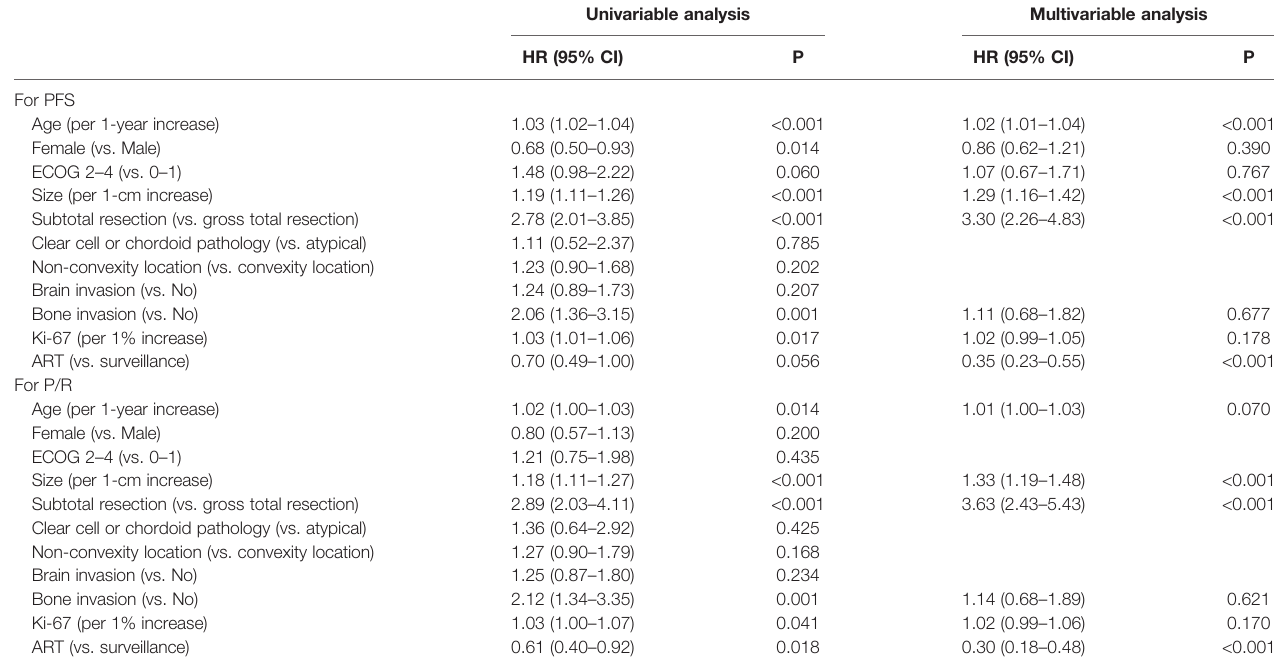
TABLE 2 | Prognostic factors for PFS and P/R in the entire